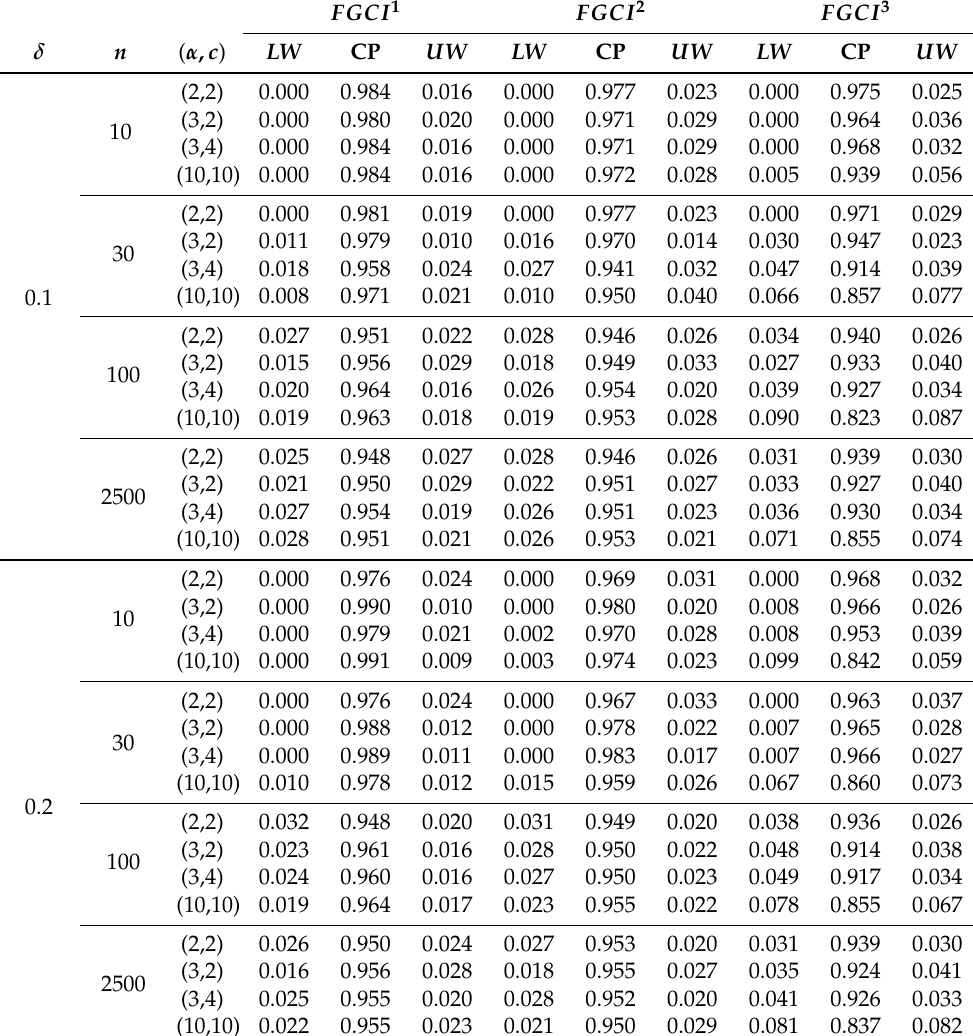
Table 1. Coverage probabilities for the mean of a sample with small proportions of zeros.